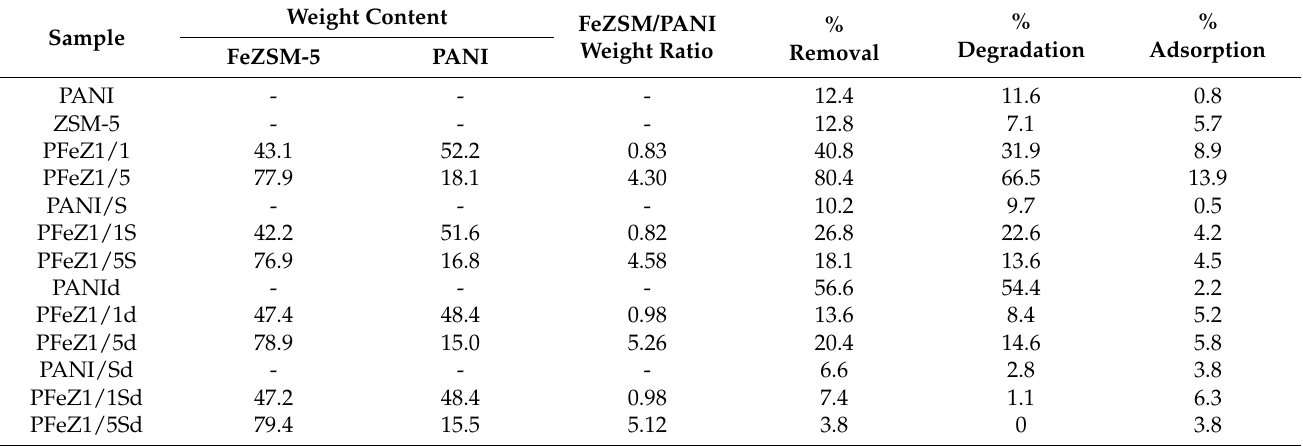
Table 7. Weight contents, percentage removal, degradation, and adsorption in composites. Reprinted with permission from Ref. [33]. Copyright 2018